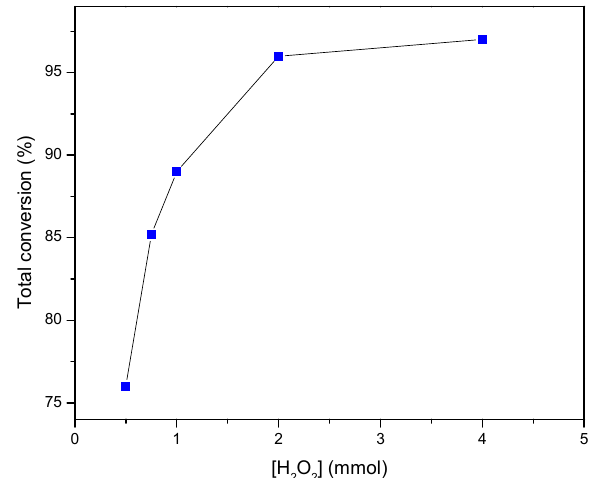
Figure 3. Total conversion of styrene to its oxygenates catalyzed by 3 at varying H 2 O 2 concentrations.